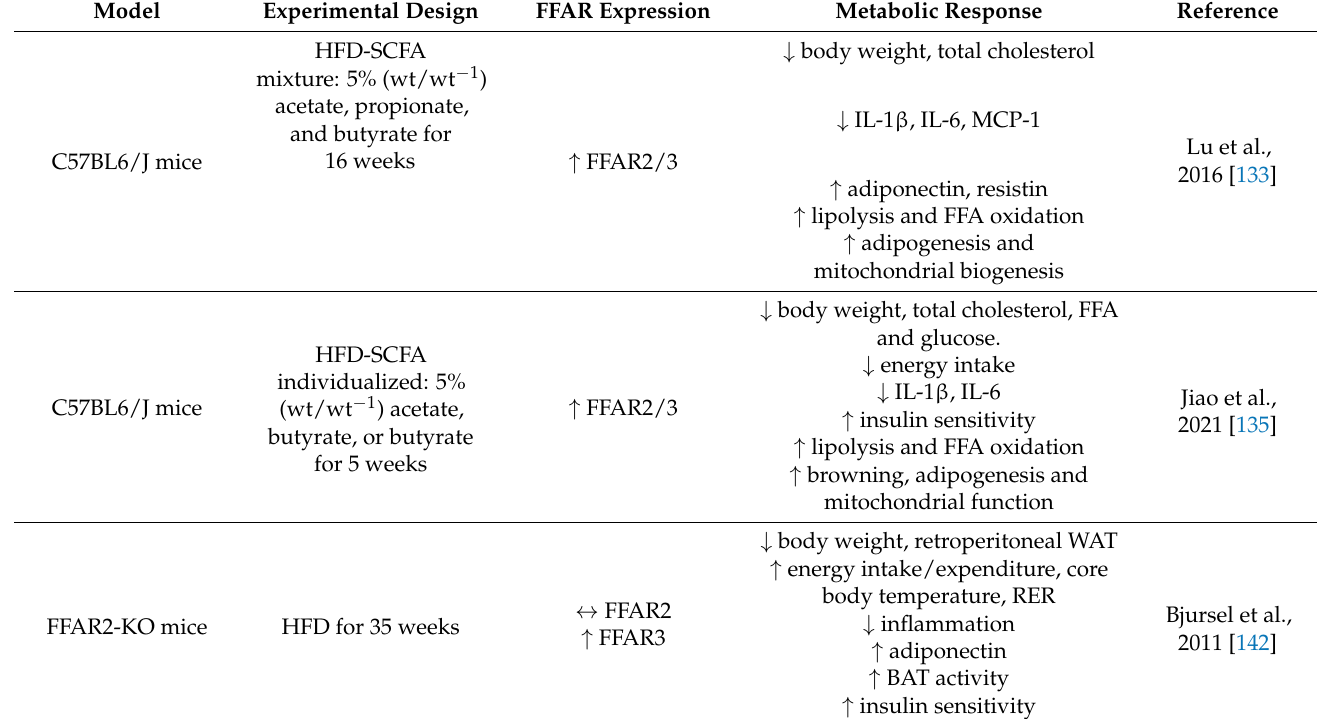
Table 1. Short chain fatty acid receptor signaling in host adipose tissue